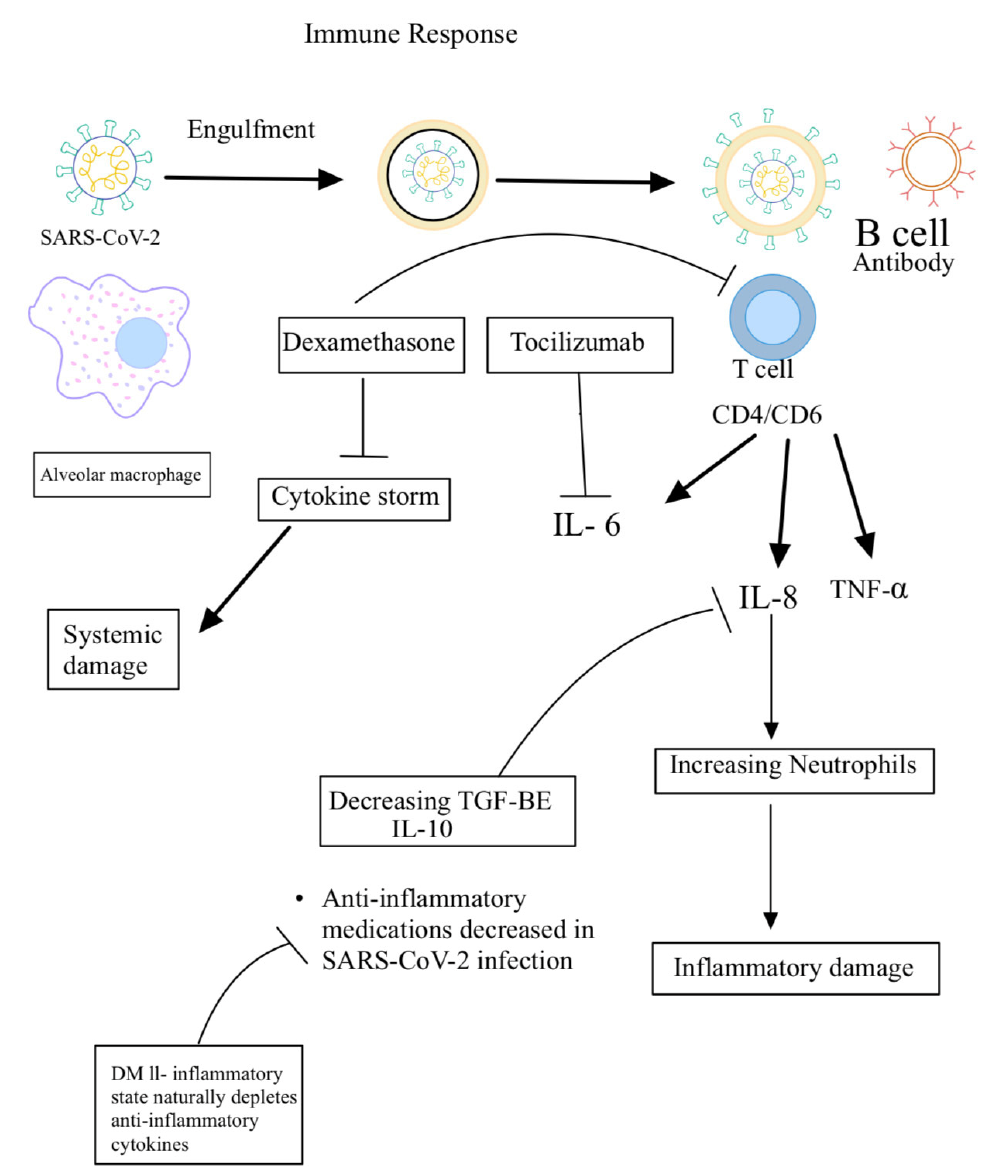
Figure 2. Underlying host immune responses against SARS-CoV-2